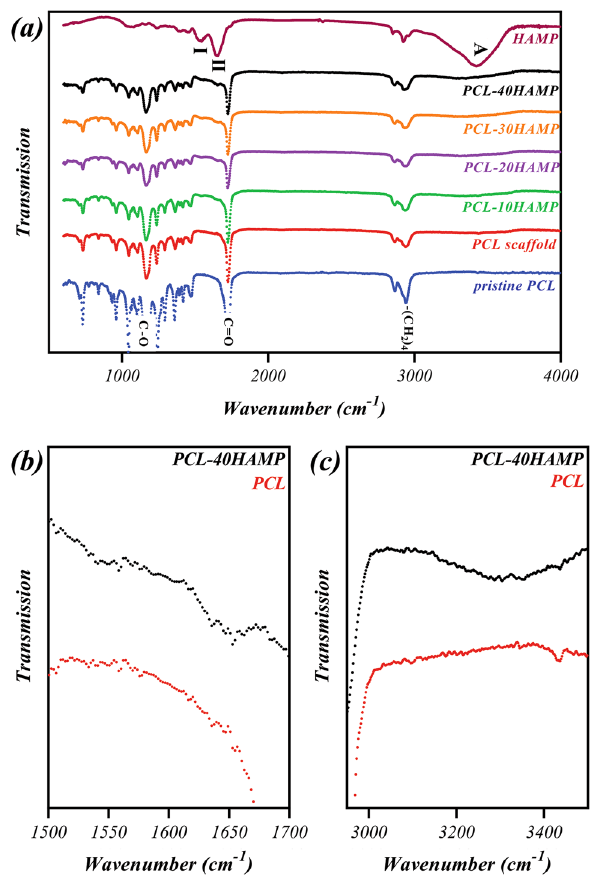
Figure 8. FTIR spectra of (a) PCL and PCL/HAMP scaffolds in the 600–4000 cm −1 region, (b) PCL and PCL- 40HAMP scaffolds in the 1500–1700 cm −1 region, (c) PCL and PCL-40HAMP scaffolds in the 3000–3500 cm −1 region.